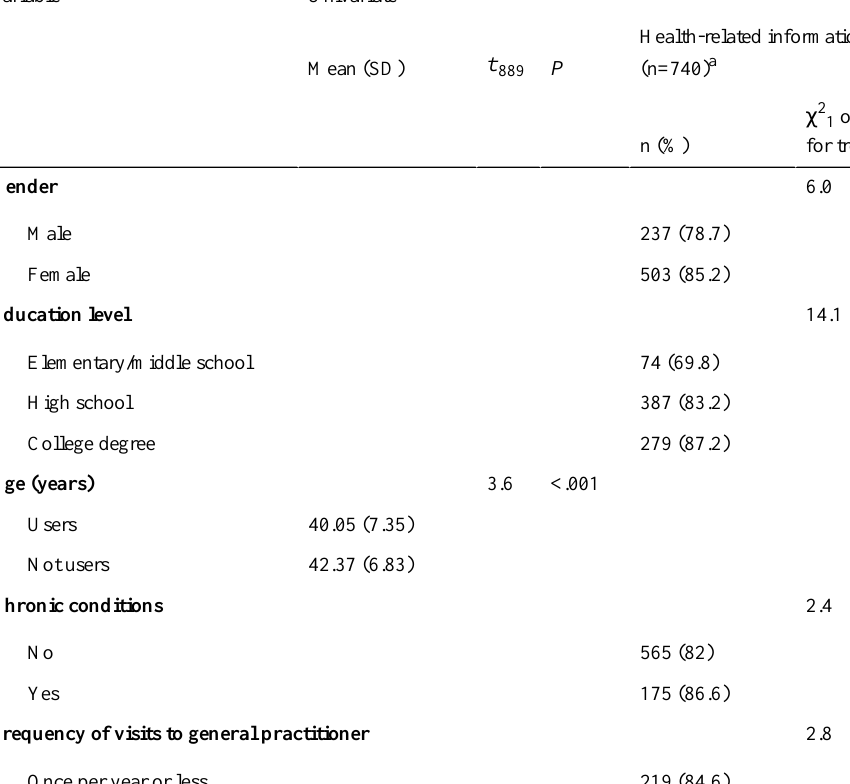
Table 3. Univariate and multivariate analyses of Internet use for health-related information seeking according to various explanatory variables.